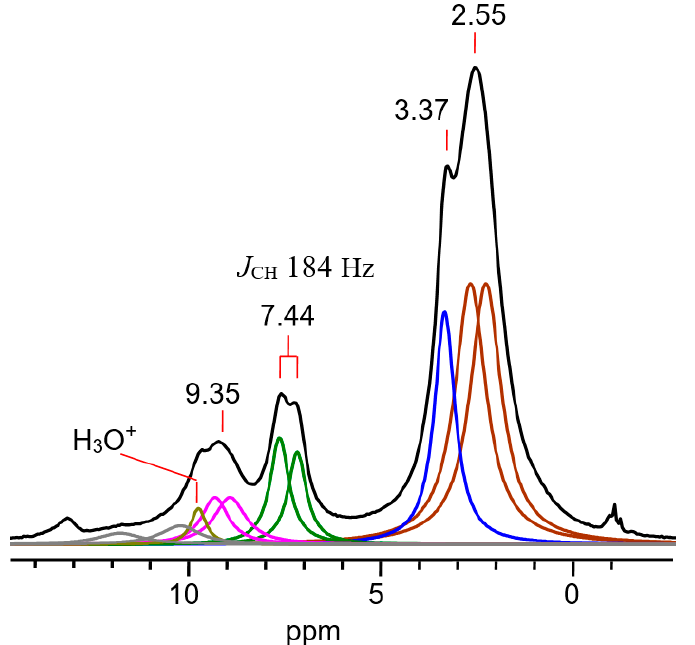
Figure 7. The 1 H MAS NMR spectrum of the C 4 H 5 + {Cl 11 − } salt. The components of each split signal are shown in one color.